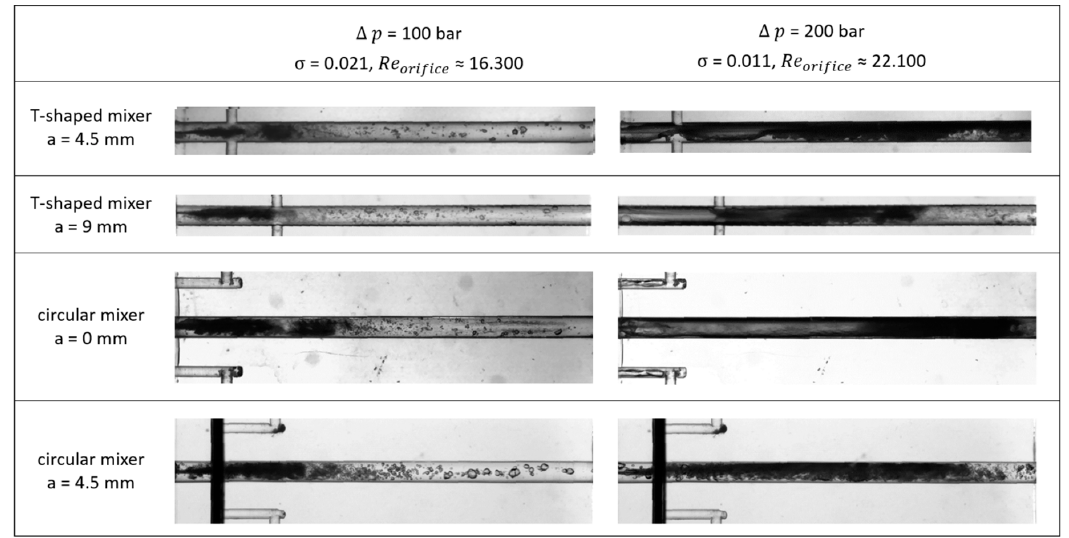
Figure 10. Cavitation patterns captured for different geometries of the mixing unit.